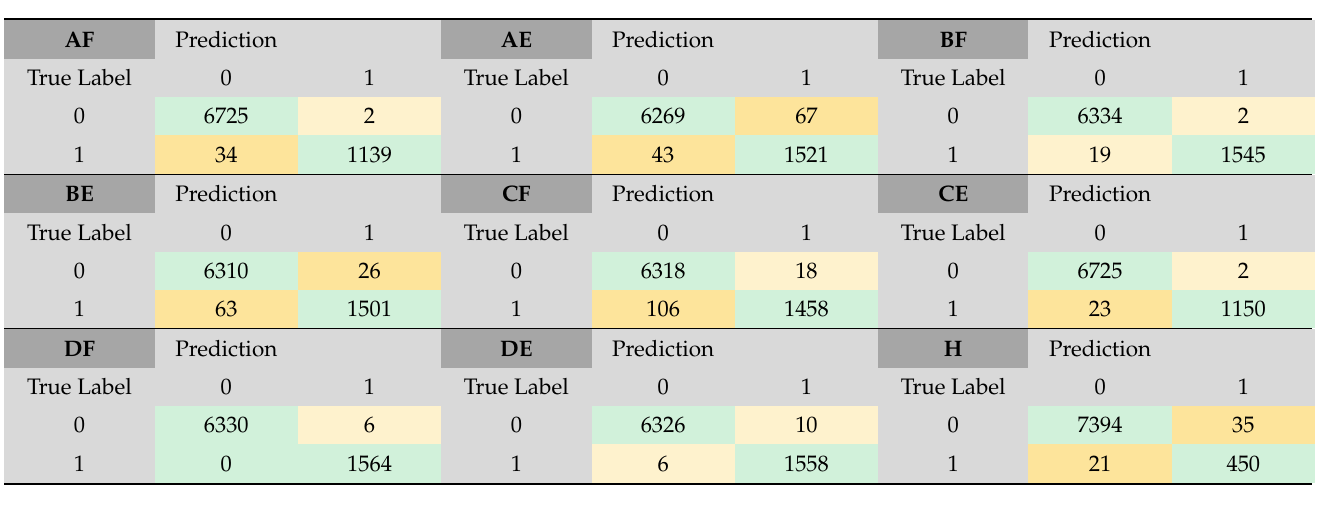
Table 8. Confusion matrices for CNN-based fault